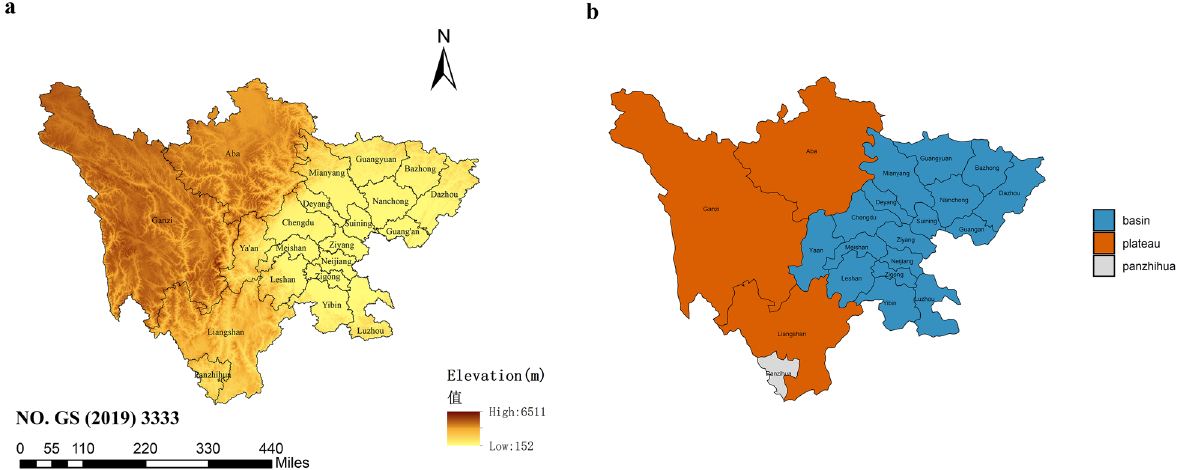
Figure 6. ( a ) Elevation of Sichuan Province; ( b ) Basin and plateau regions in Sichuan Province. The original map image was obtained from the China Ministry of Natural Resources (http:// bzdt. ch. mnr. gov. cn/ index.